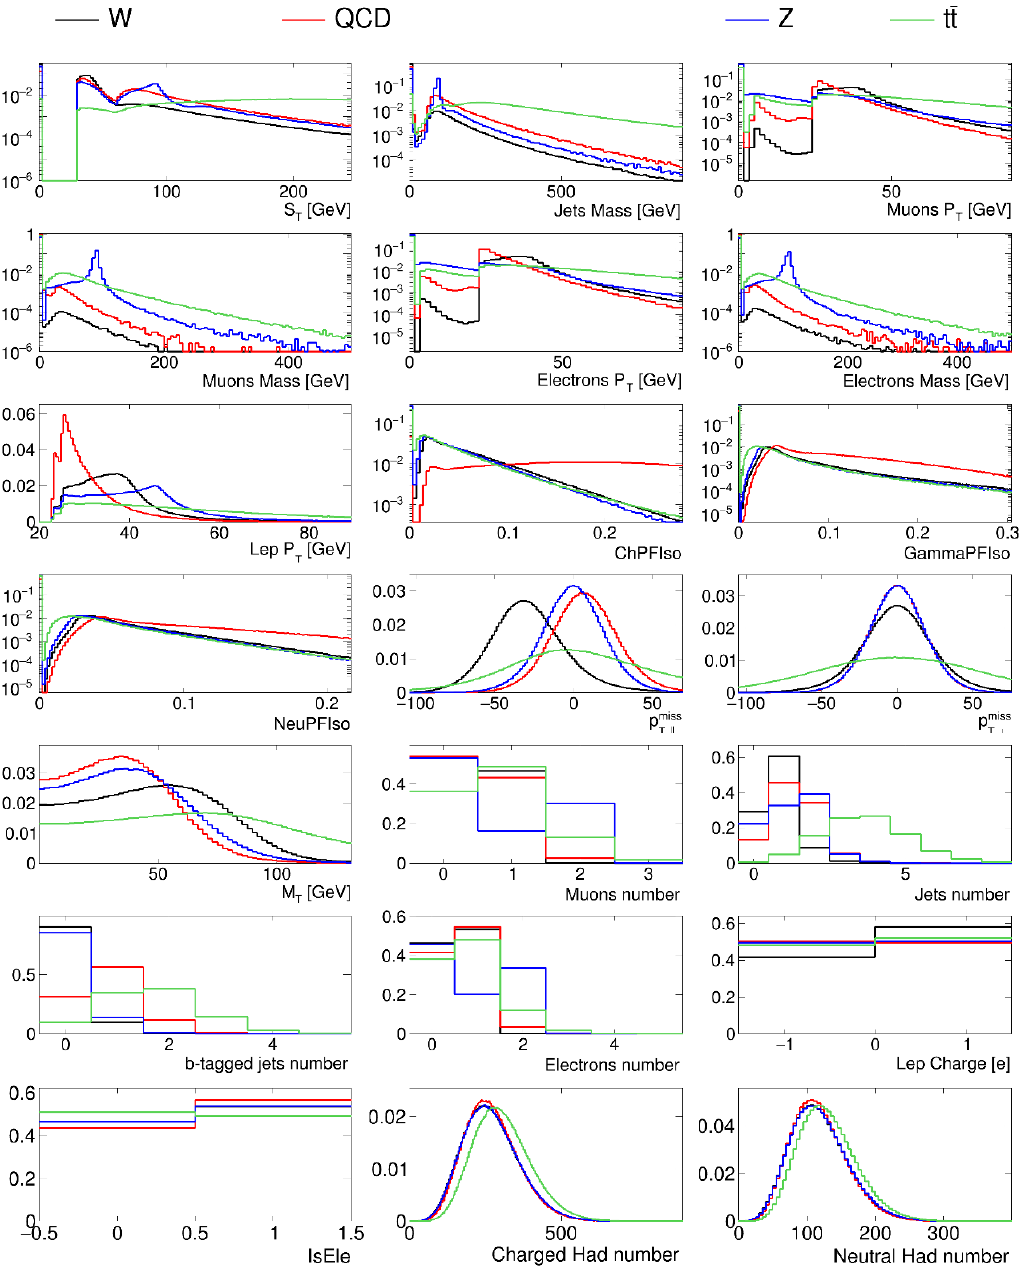
Figure 1 . Distribution of the HLF quantities for the four considered SM processes.